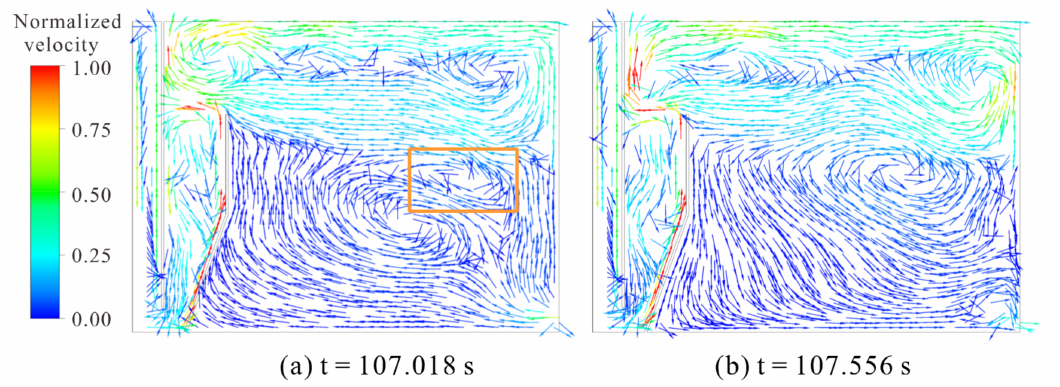
Figure 6. Switching process from clockwise to